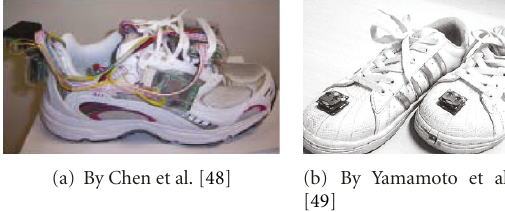
Figure 14: Examples of smart shoes with integrated